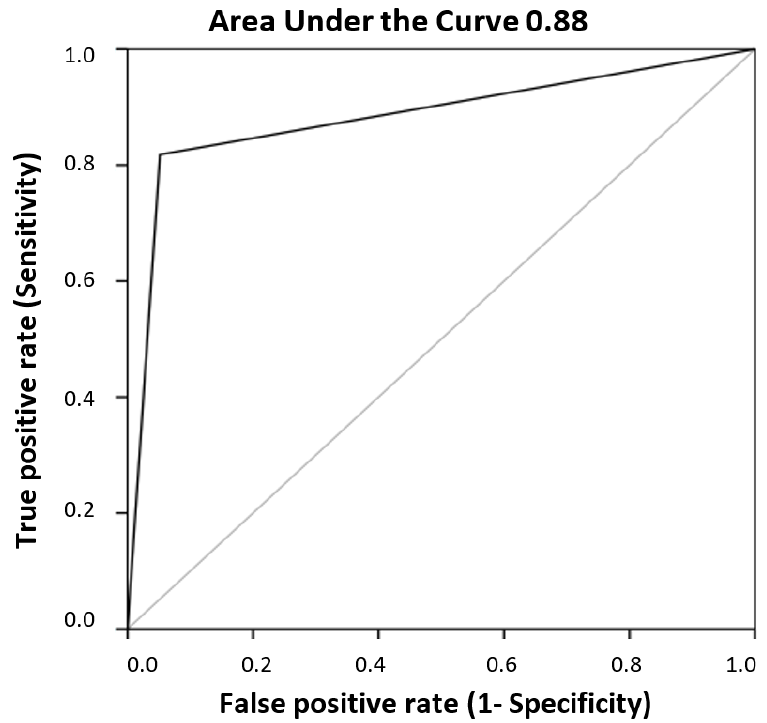
Figure 3. The Receiver Operating Characteristic (ROC) curve resulting from the two criteria used to pick possible subjects at risk for